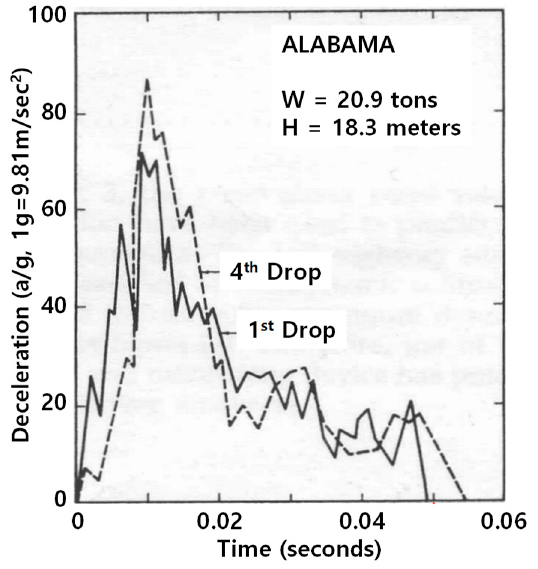
Figure 8. Curve of deceleration response measured during dynamic compaction tests (Paul et al., 1984).